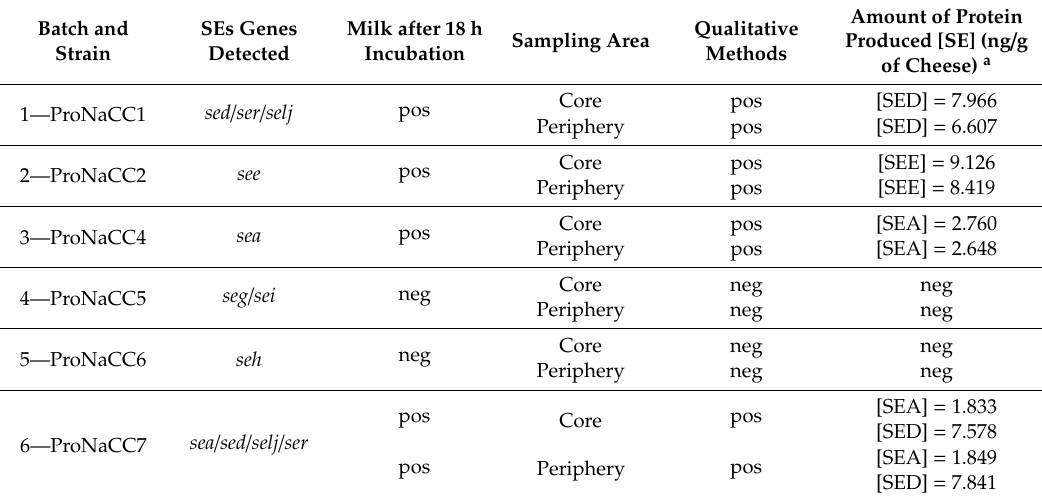
Table 8. Enterotoxins production in vivo: immunochemical qualitative and quantitative methods. Batch and Strain